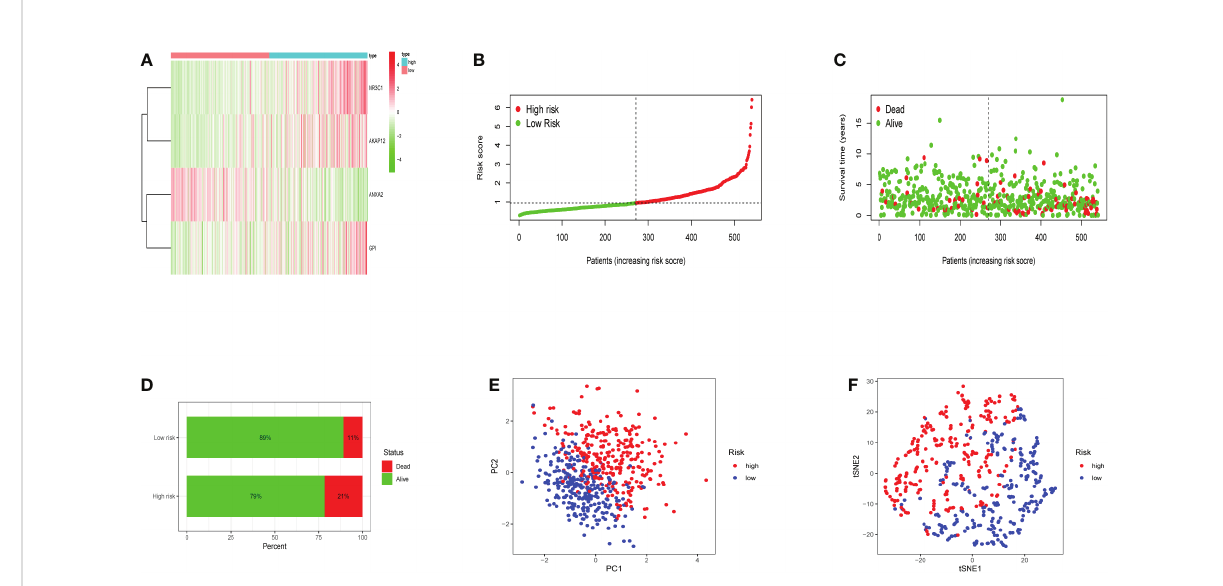
FIGURE 3 The expression levels of the four genes included in the model and the prediction of patient risk in the hypoxia model. (A) Heatmaps of four gene expression levels in the risk model for the high- and low-risk groups. (B) Patient risk scores in the high- and low-risk groups. (C) Survival rates in the high- and low-risk groups. (D) Patient survival in the high- and low-risk groups. (E, F) Principal component analysis (PCA) plot and t- distributed stochastic neighbor embedding (t-SNE) for the different gene expression patterns of samples.